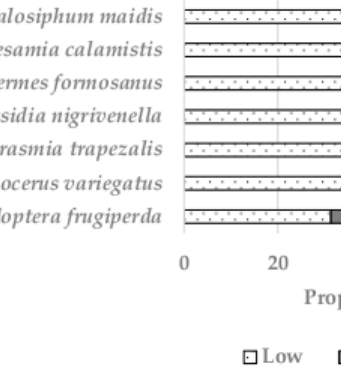
Figure 2. Farmers’ perceptions of damage from maize